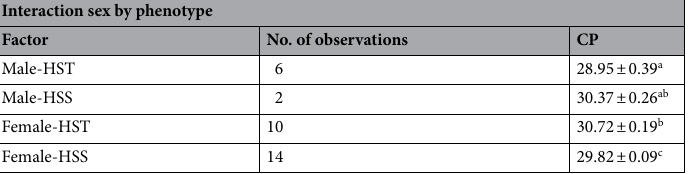
Table 7. The least squares mean interaction on crossing point value (CP) between sex by phenotype. No Number or sample size; CP Crossing point value; Male-HST Male-Heat stress tolerant phenotype; Male-HSS Male-Heat stress susceptible phenotype; Female-HST Female-Heat stress-tolerant phenotype; Female-HSS Female-Heat stress susceptible phenotype; Means ± SE Means ± Standard Error, means within the same rows with different superscripts are significantly different ( p < 0.01).